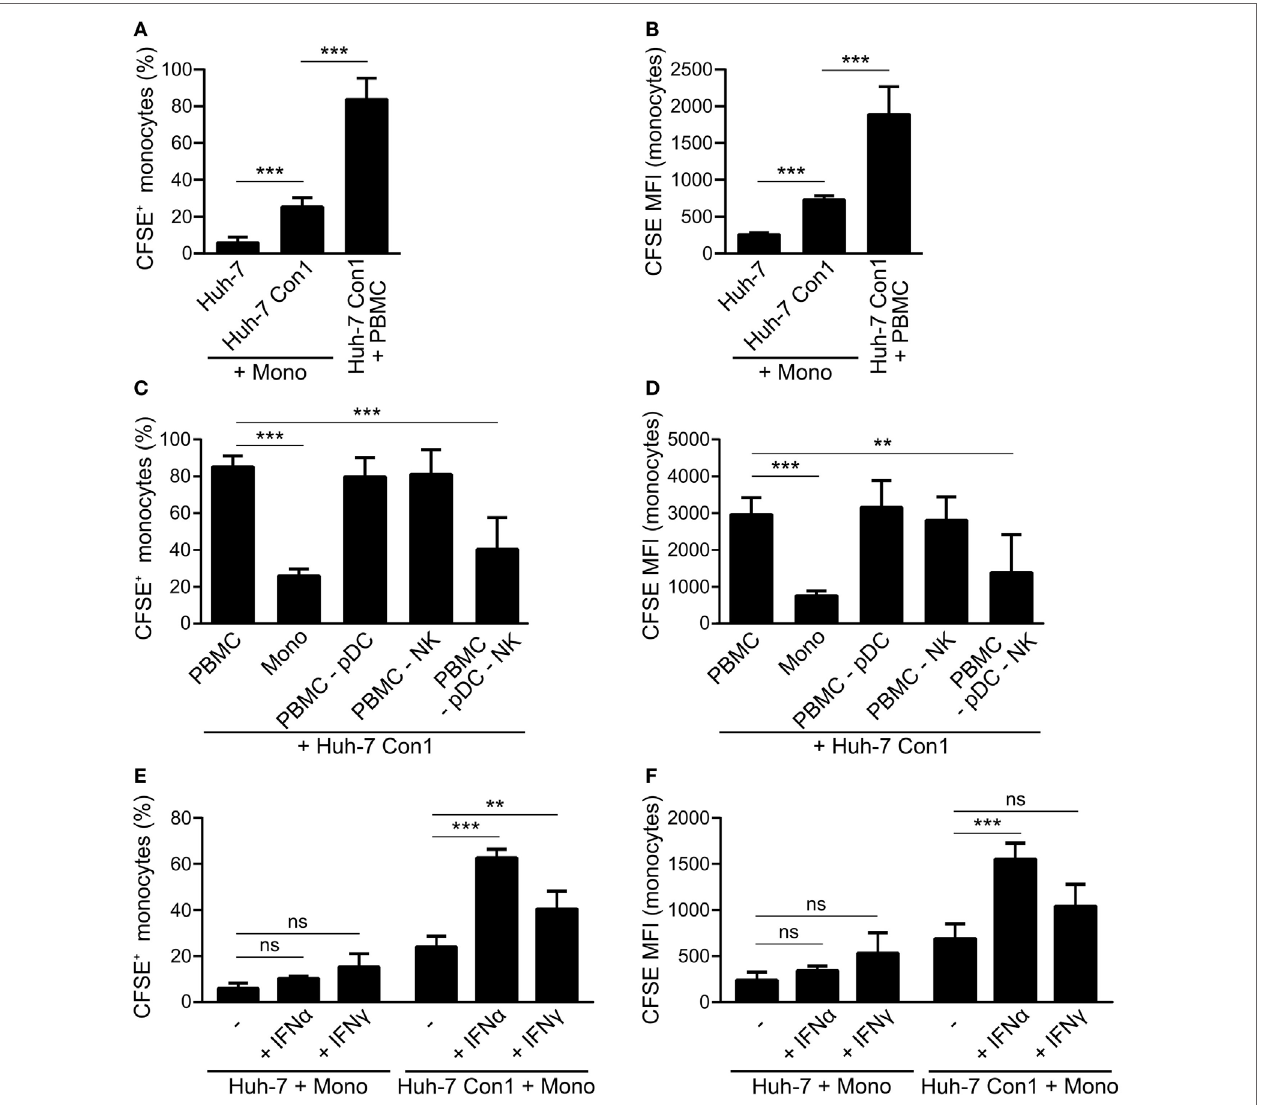
FigUre 4 | Plasmacytoid dendritic cells (pDCs) and natural killer (NK) cells promote phagocytosis of hepatitis C virus subgenomic replicon by monocytes. (a,B) Purified monocytes (Mono) or peripheral blood mononuclear cells (PBMCs) were co-cultured with carboxyfluorescein succinimidyl ester (CFSE) stained Huh-7 cells overnight. Percentage of CFSE + monocytes (a) and CFSE mean fluorescence intensity (MFI) of monocytes (B) was determined ( n = 5). (c,D) CFSE stained Huh-7 Con1 cells were co-cultured overnight with PBMCs, purified monocytes (Mono), PBMCs depleted from pDCs (PBMC -pDC), PBMCs depleted from NK cells (PBMC -NK) or with PBMC depleted from pDCs and NK cells (PBMC -pDC -NK). CFSE + monocytes were determined ( n = 3). (e,F) Purified monocytes were co-cultured with CFSE stained Huh-7 cells in presence of recombinant IFN α (700 pg/ml) or recombinant IFN γ (7 ng/ml). CFSE + monocytes were determined ( n =